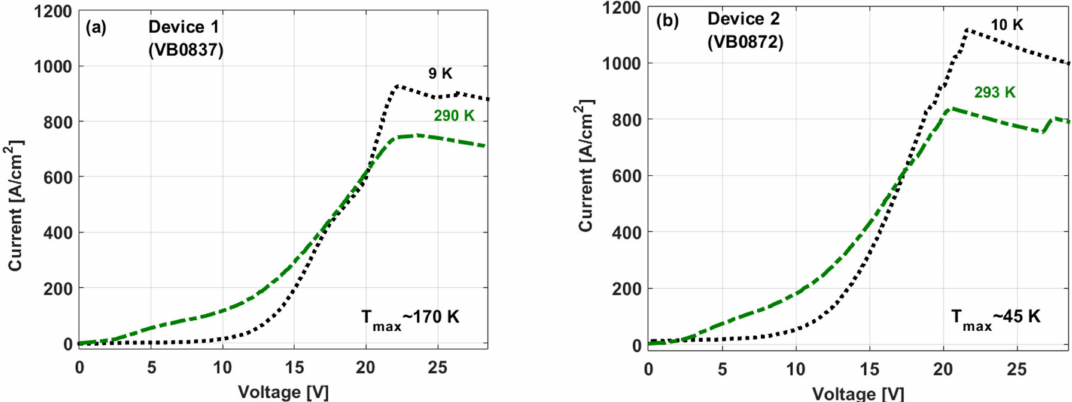
Figure 3. I–V curves for: ( a ) Device 1 (VB0837, 1 × doping) [34] and ( b ) Device 2 (VB0872, 2 × doping) at low and room temperatures. T max values are also shown.